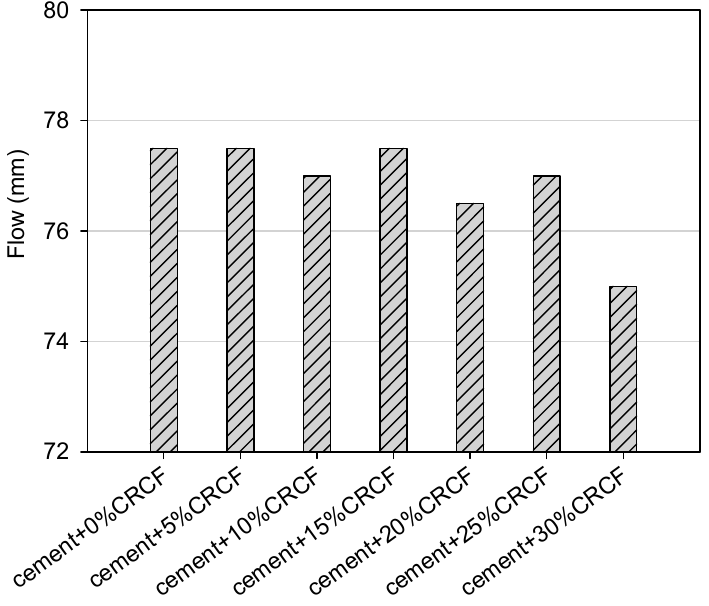
Figure 9. Effect of CRCF on the flow of fresh mixtures.